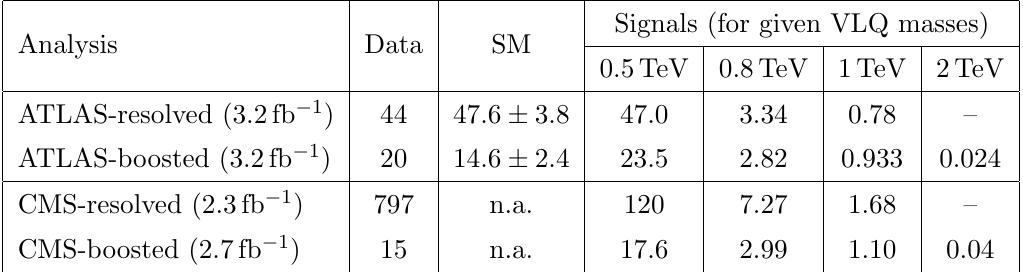
Table 1 . Number of data and predicted signal and background events for four VLQ masses of M Q = 500, 800, 1000, and 2000 GeV, as obtained in the four reinterpreted LHC analyses and for (cid:20) T = 0 :